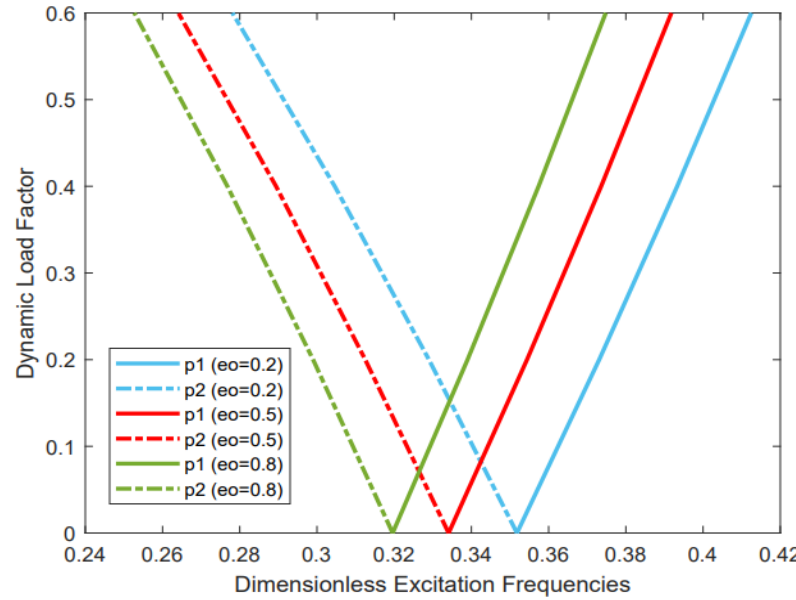
Figure 5. The effect of the porosity coefficient.